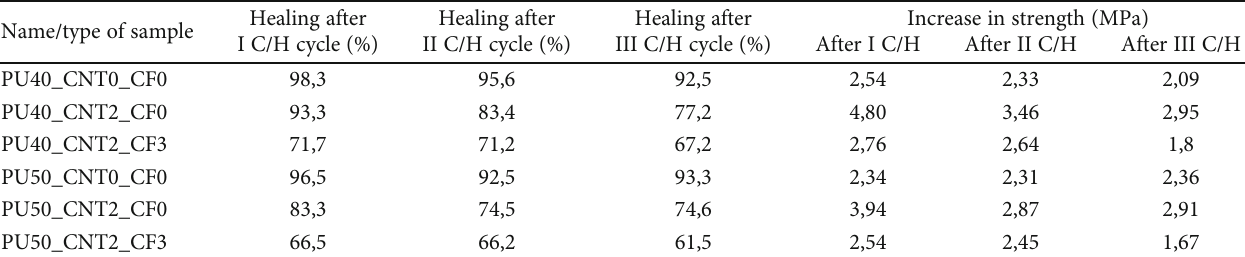
Table 3: Comparison of healing e ff ects of di ff erent samples and increases in strengths of damaged samples after C/H cycles. Healing Name/type of sample